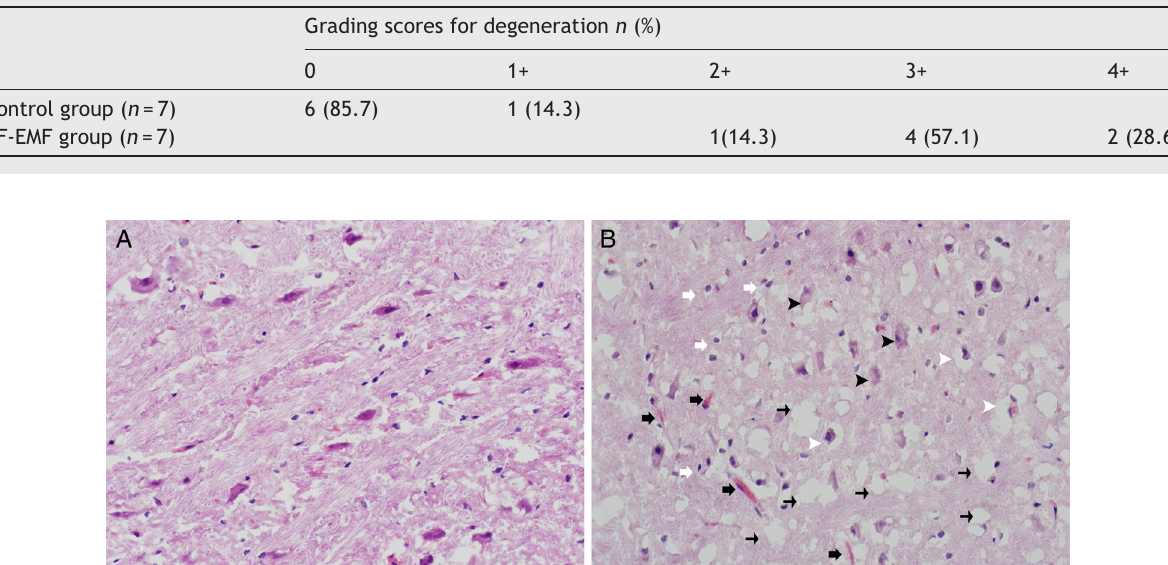
Grading scores for degeneration in groups.